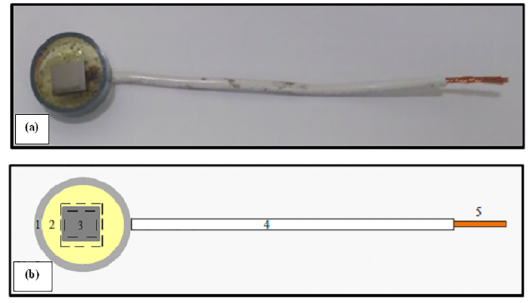
Figure 1. (a) ASTM A131 grade A36 carbon steel sample used for electrochemical tests. (b) Representative diagram: 1 - PVC pipe, 2 - epoxy resin, 3 - delimited area of specimens, 4 - encapsulated copper wire that was welded to metal, 5 - bare copper wire to maintain electrical contact. The dotted region corresponds to the stretch isolated with high adherence tape.